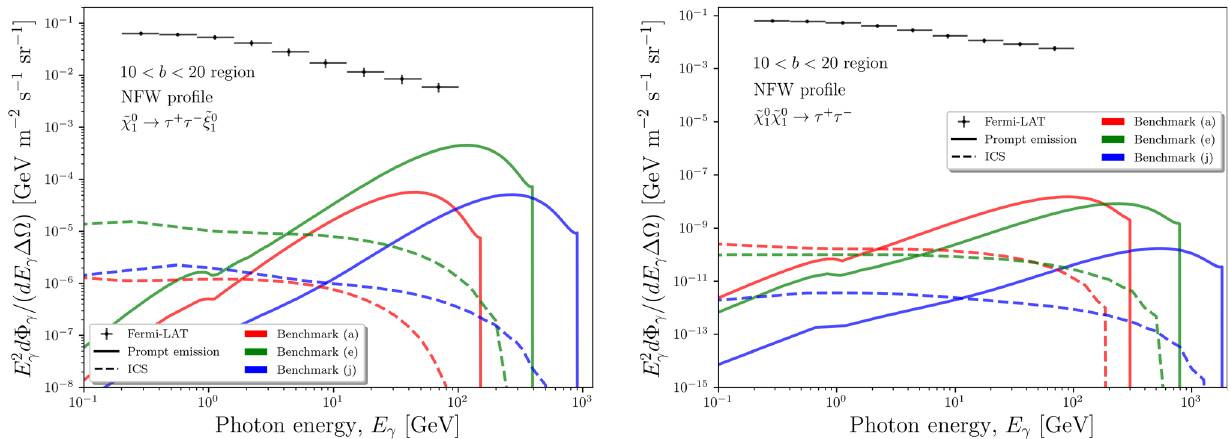
for three benchmarks of Table 1 due to prompt emission 1